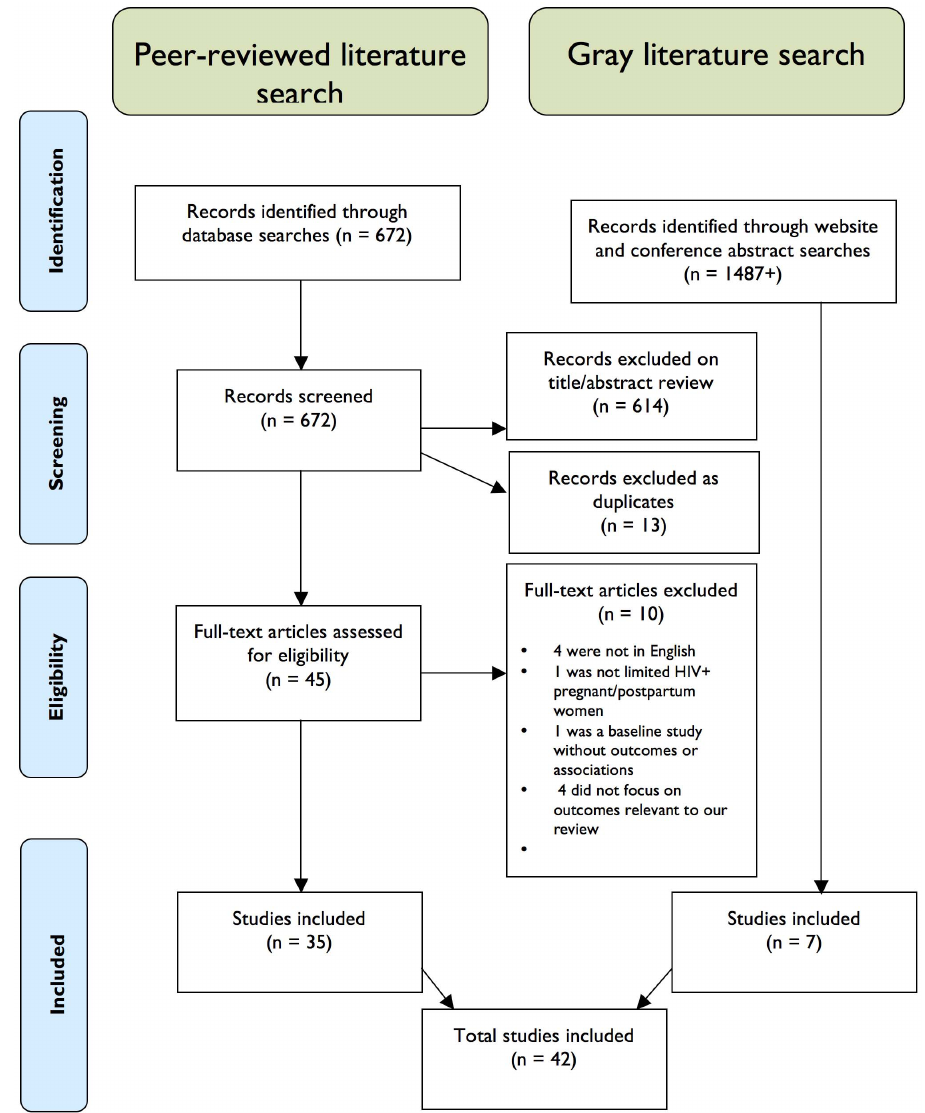
Figure 1. Flow Diagram for Study Search and Inclusion.